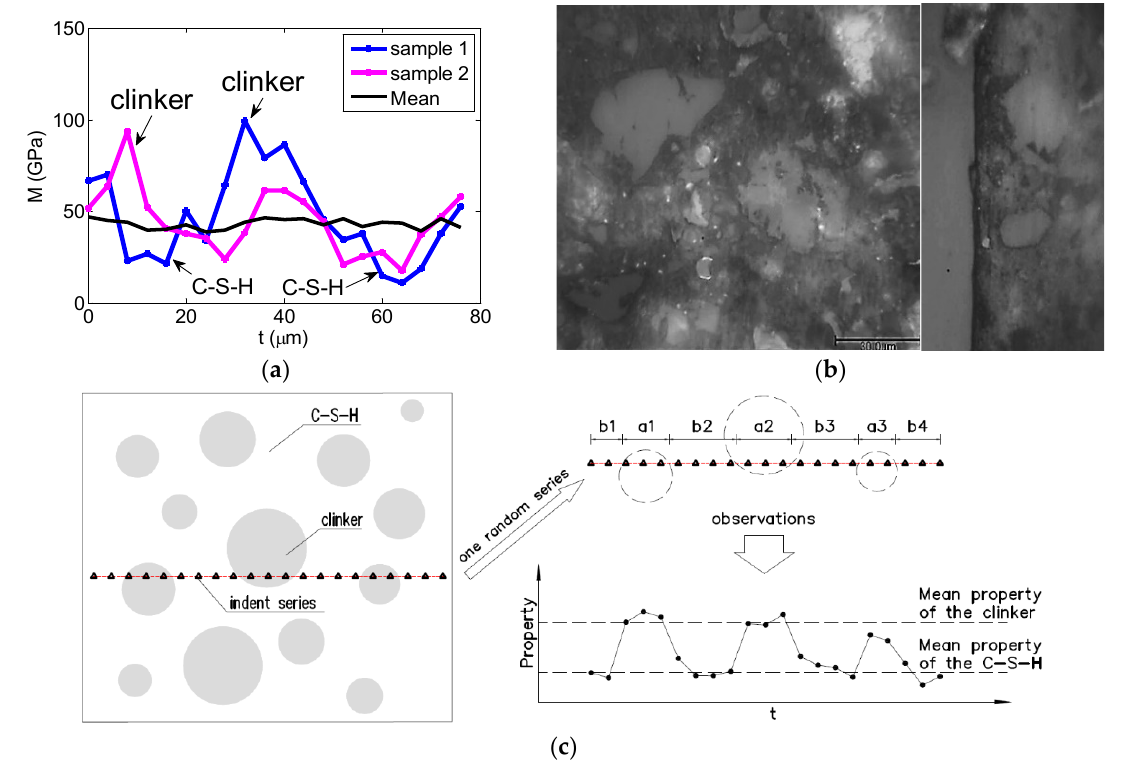
Figure 10. The scale of fluctuation and the nanostructure of cementitious materials: ( a ) random series (samples); ( b ) image picture; ( c ) the clinker- C-S-H system. Table 6. The values of factors in Equation (10).